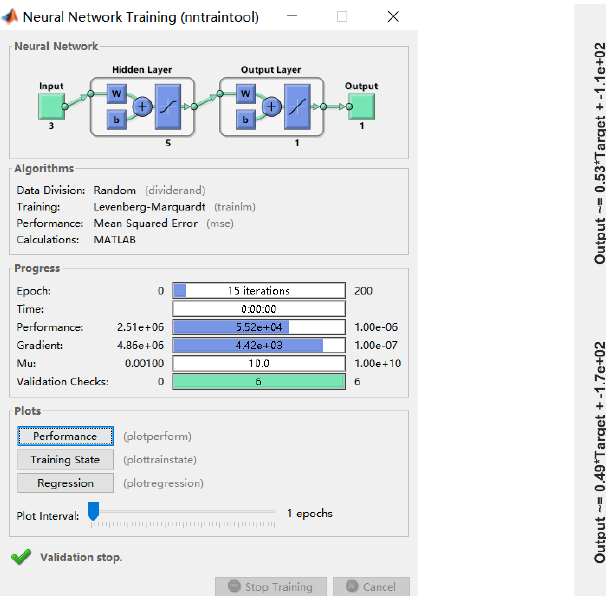
Figure 11. Schematic diagram of abnormal data error.